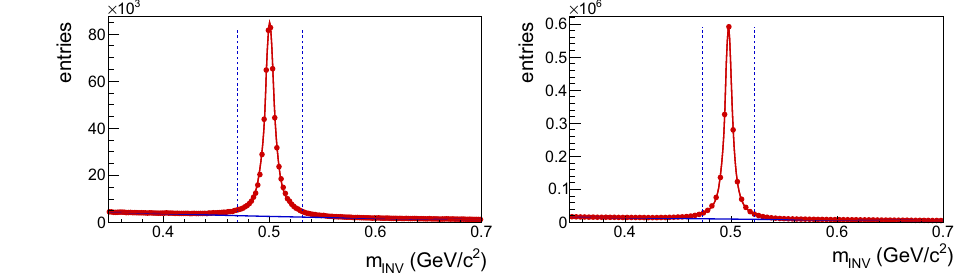
Fig. 5 The invariant mass distribution of K 0 candidates for experi- fit results in red. The uncertainties are smaller than symbol size and S mental data ( left ) and MC ( right ). The dashed vertical lines indicate not visible on the plots. Mass resolutions obtained from the fits are: σ = ( 0 . 01026 ± 0 . 00002 ) GeV / c 2 for the experimental data and the regions over which the K 0 signal was integrated. The signal data S σ = ( 0 . 00819 ± 0 . 00001 ) GeV / c 2 for the points are shown in red, the fitted background in blue and the total